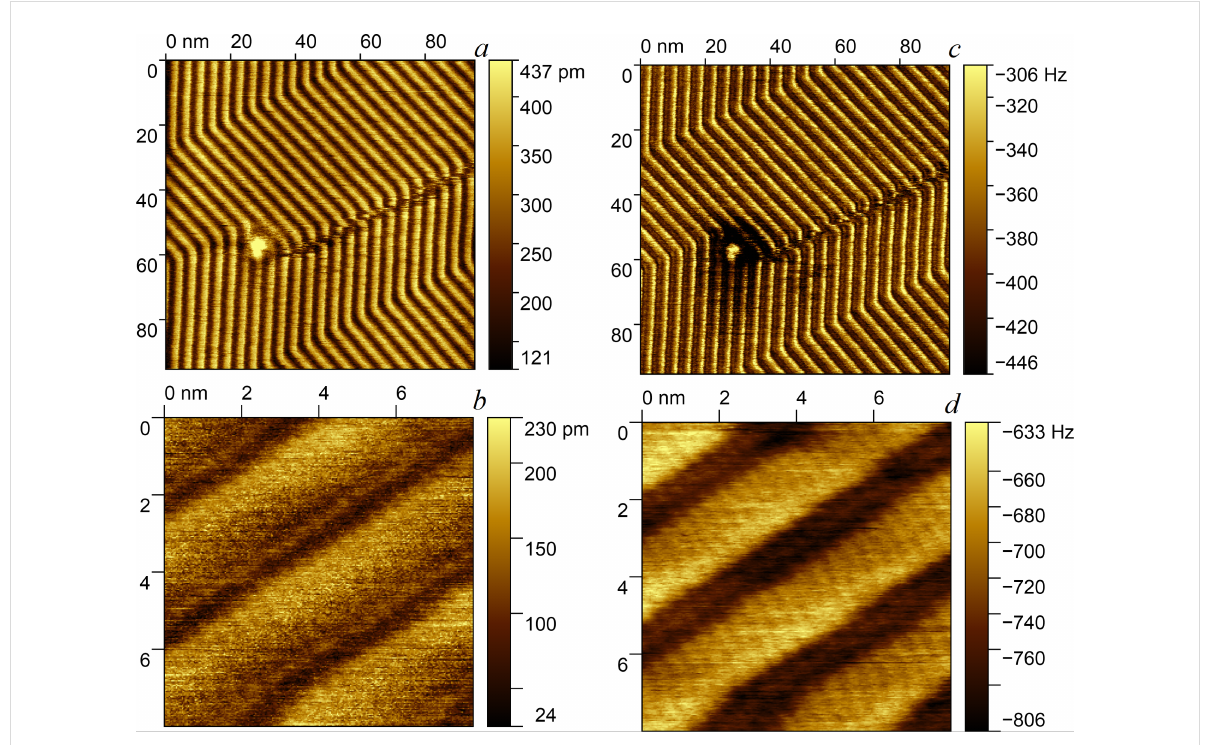
Figure 4: Dissipation mode. Self-organization of palmityl palmitate on graphite. Topography (a, b) and shift of the resonant frequency of the probe (c,